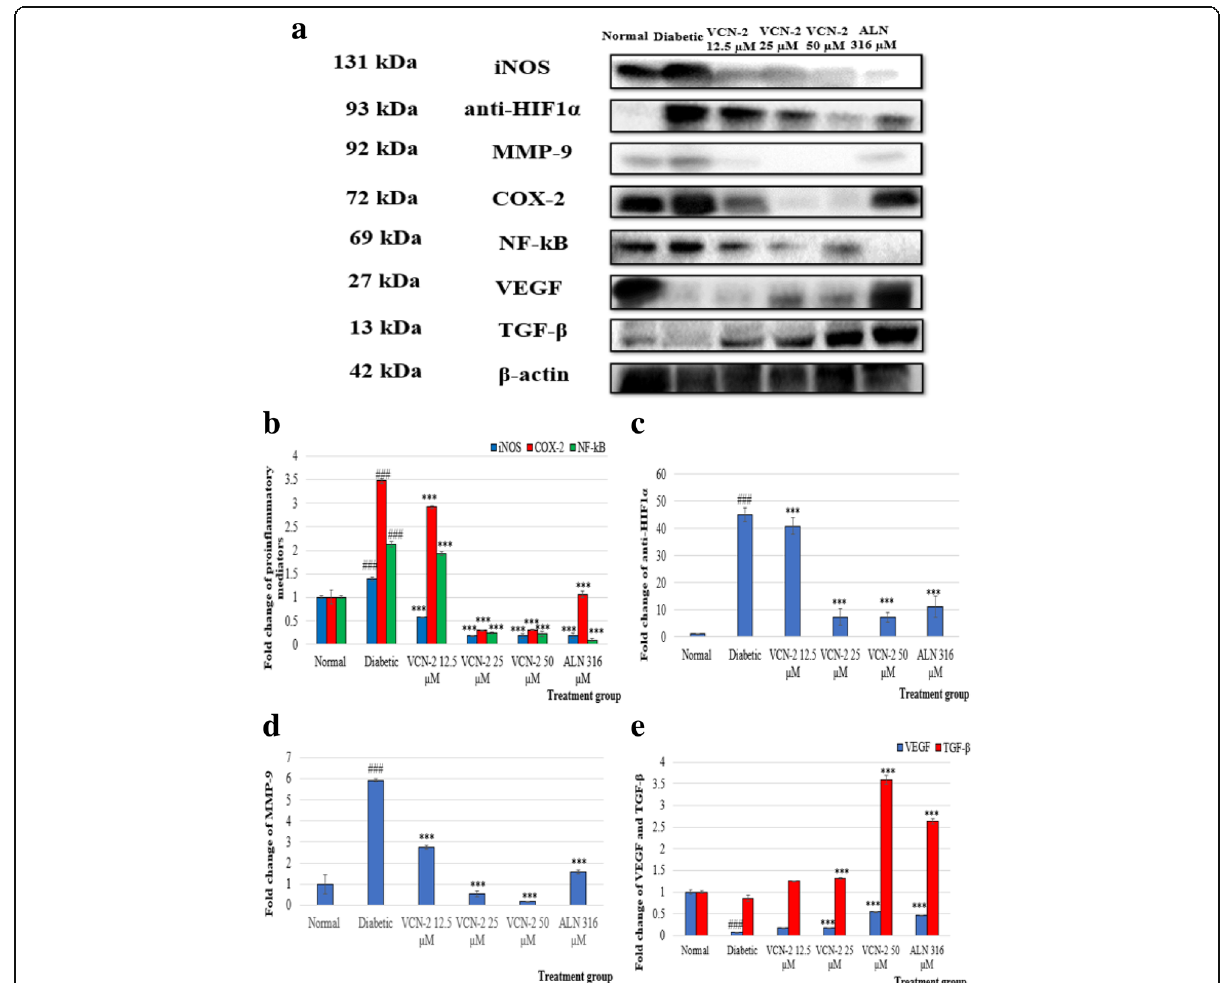
Fig. 6 a Effect of VCN-2 hydrocolloid film on expression of mediators after 14 days treatment was detected by Western blotting. Down-regulation of various anti-inflammatory and up-regulation of expression of several wound healing markers in skin tissues were observed. β -actin acted as control marker. b Effect of VCN-2 film on expression of mediators after 14 days topically treatment was detected by immunoblotting. A graph represented densitometry analysis results of the effect of VCN-2 on proteins expression proinflammatory mediators ( c ) anti-HIF1 α , ( d ) MMP-9, and ( e ) VEGF and TGF- β . All data are expressed as mean±SEM. ### p <0.001 represented statistical difference diabetic group compared to normal group; *** p < 0.001 represented statistical difference treatment groups compared to the diabetic